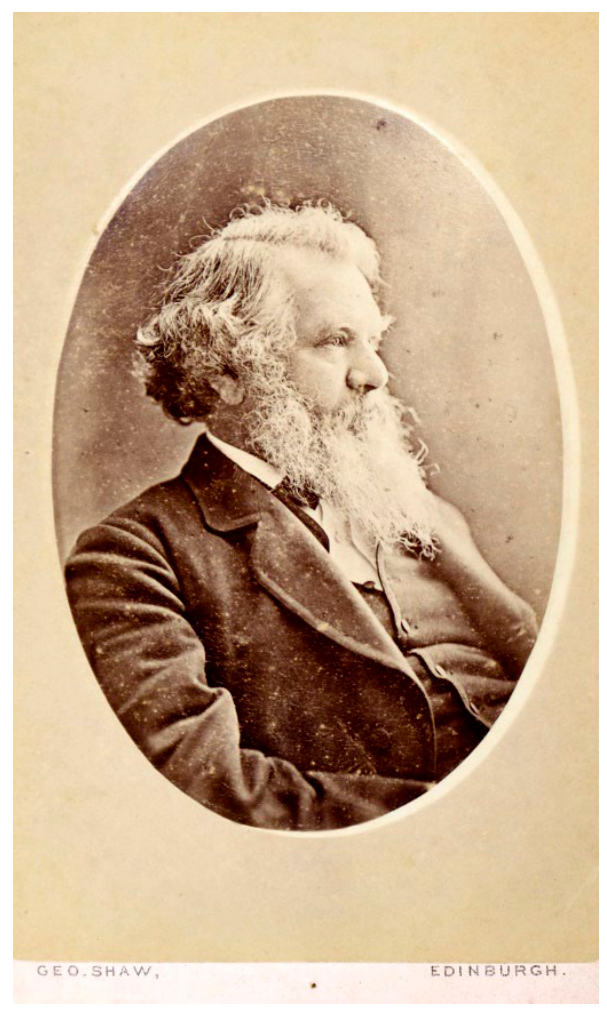
Figure 2. Edmund Ronalds, photographed in May 1878 by George Shaw in Edinburgh. Source: Sir George Grey Special Collections, Auckland Library, New Zealand, NZMS